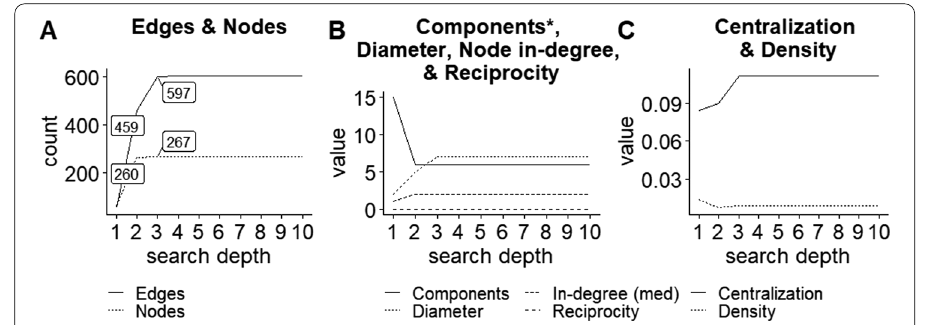
Fig. 3 Panels A – C show node and graph level statistics for the reduced root URL network at different depths. Metrics are defined in Table 1. For reference, the number of edges and nodes returned at depths two and three are labeled in panel “ A ”, since these values are discussed in the text. Further values for all metrics are provided in Additional file 1: Table S1. (*The number of components does not include the 5 isolates in the graph, described in the methods)